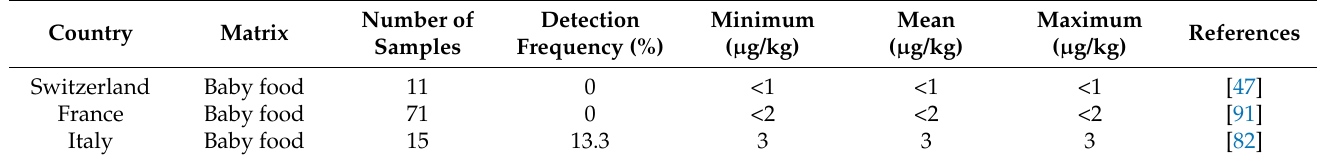
Table 9. Occurrence of glyphosate in baby